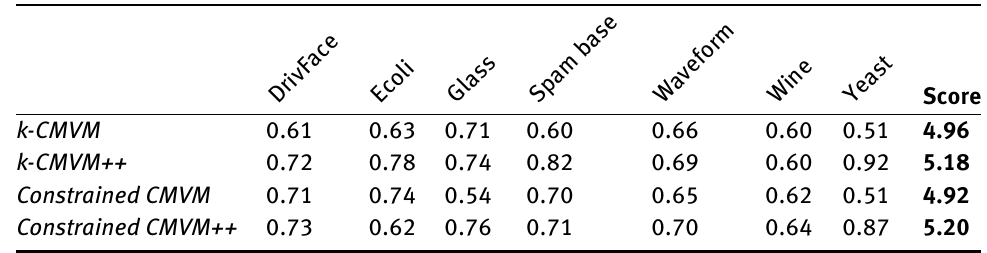
Table 7: Combined separability and structural utility